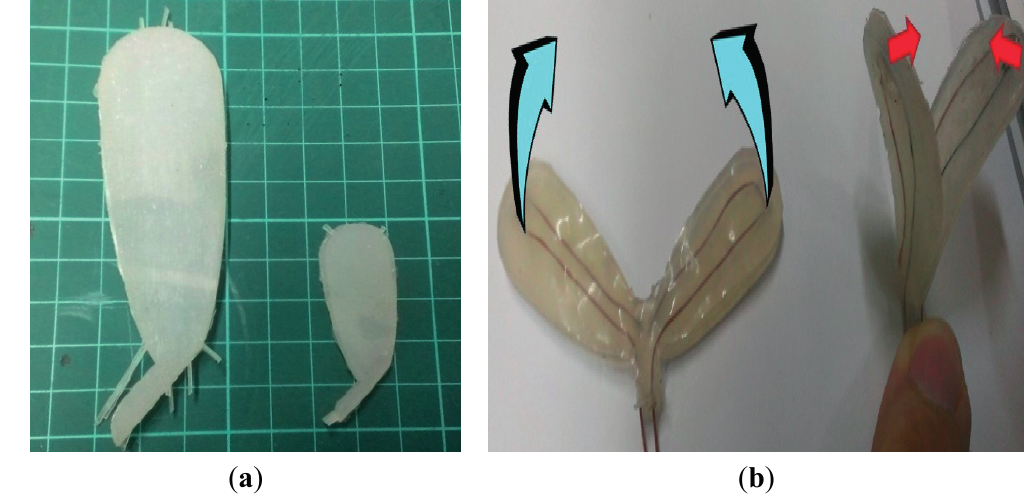
Figure 10. Appearance of completed mimosa leaves: ( a ) completed leaves; ( b ) 2-dimension leaf ( left ), and 3-dimension leaf ( right